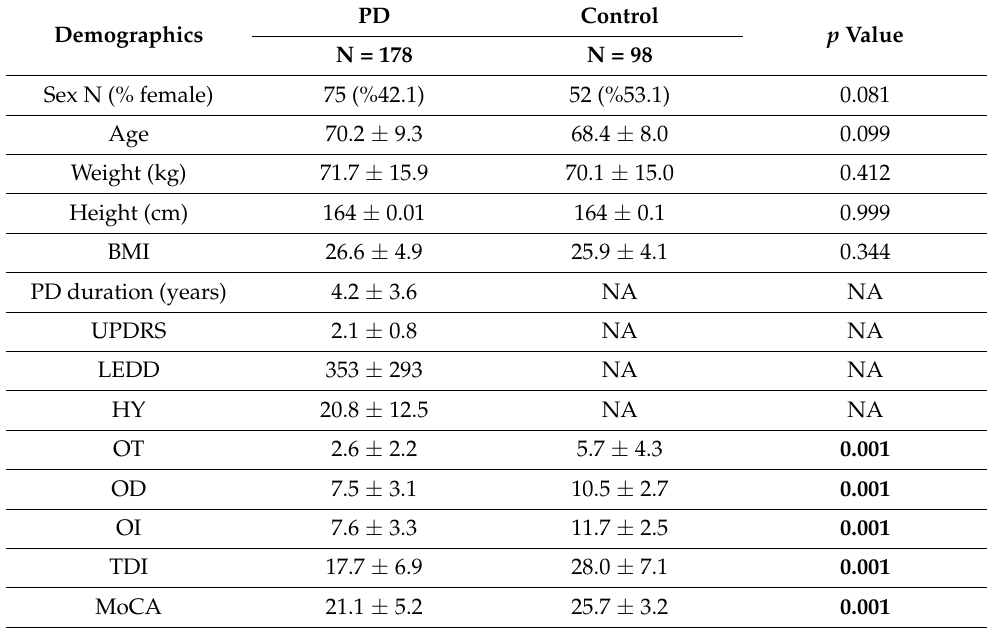
Table 1. Clinical and demographic information of all participants. Data are expressed as mean ± SD.